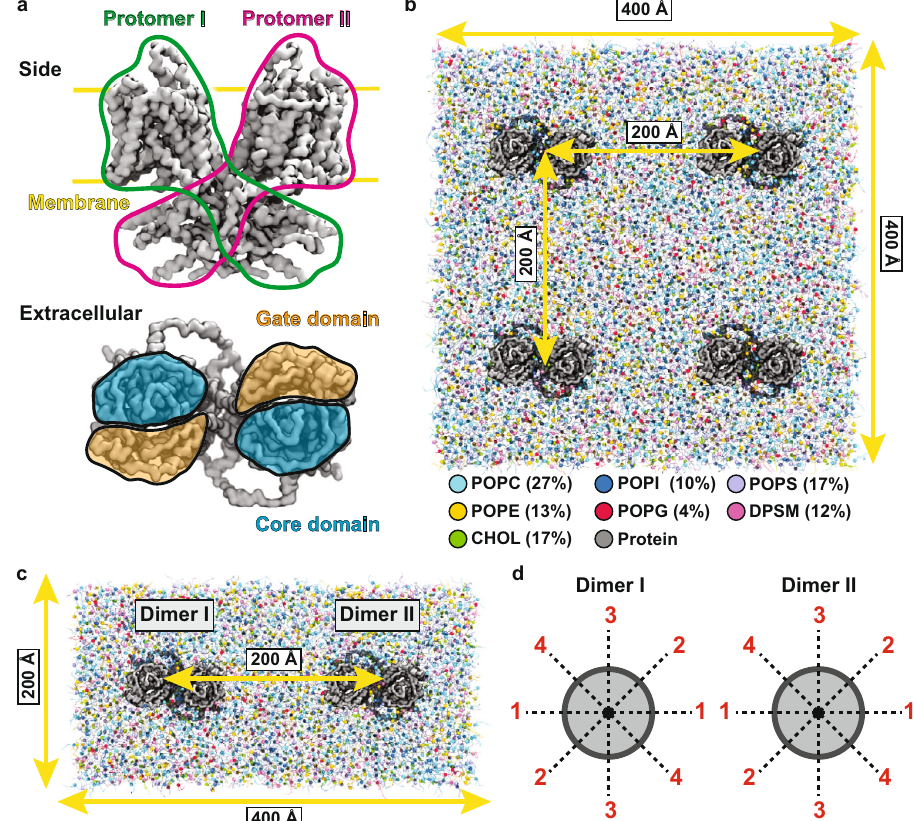
Fig. 1 | Prestin simulation systems. a MARTINI-based CG model of prestin from thesideandextracellularviews.Inthesideview,thetwoprotomersareoutlinedin greenandmagenta,respectively,andtheapproximatepositionofthemembraneis marked with yellow lines. In the extracellular view, the core and gate domains are colored in orange and blue, respectively. b Simulation system to probe lipid- protein interactions, including four prestin dimers, separated by 200 Å, and embedded in a square membrane patch of side length 400 Å. The composition of the membrane is shown in the legend, with lipid types represented with different